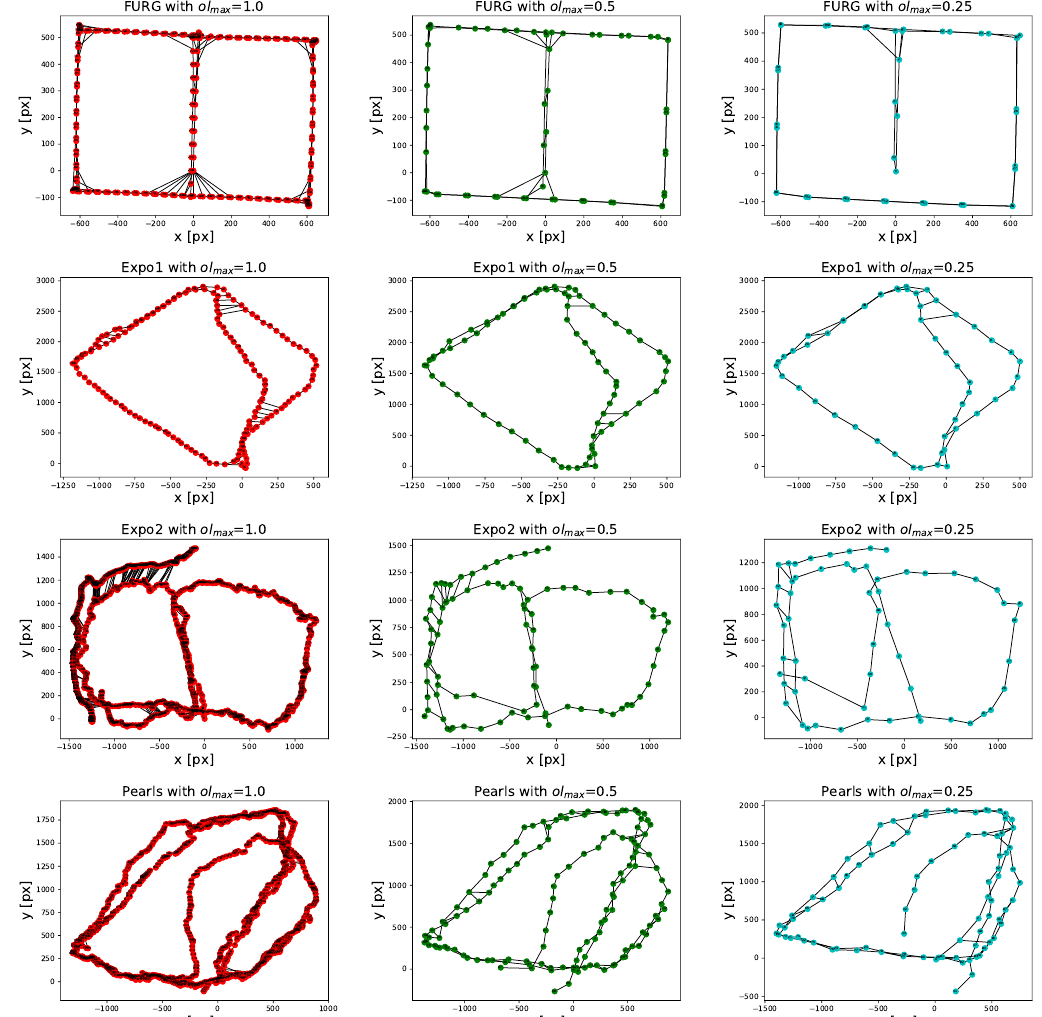
Figure 13. Obtained graphs from applying our method to each dataset varying the overlap factor ol max . ol max =1.0 ol max =0.5 ol max =0.25